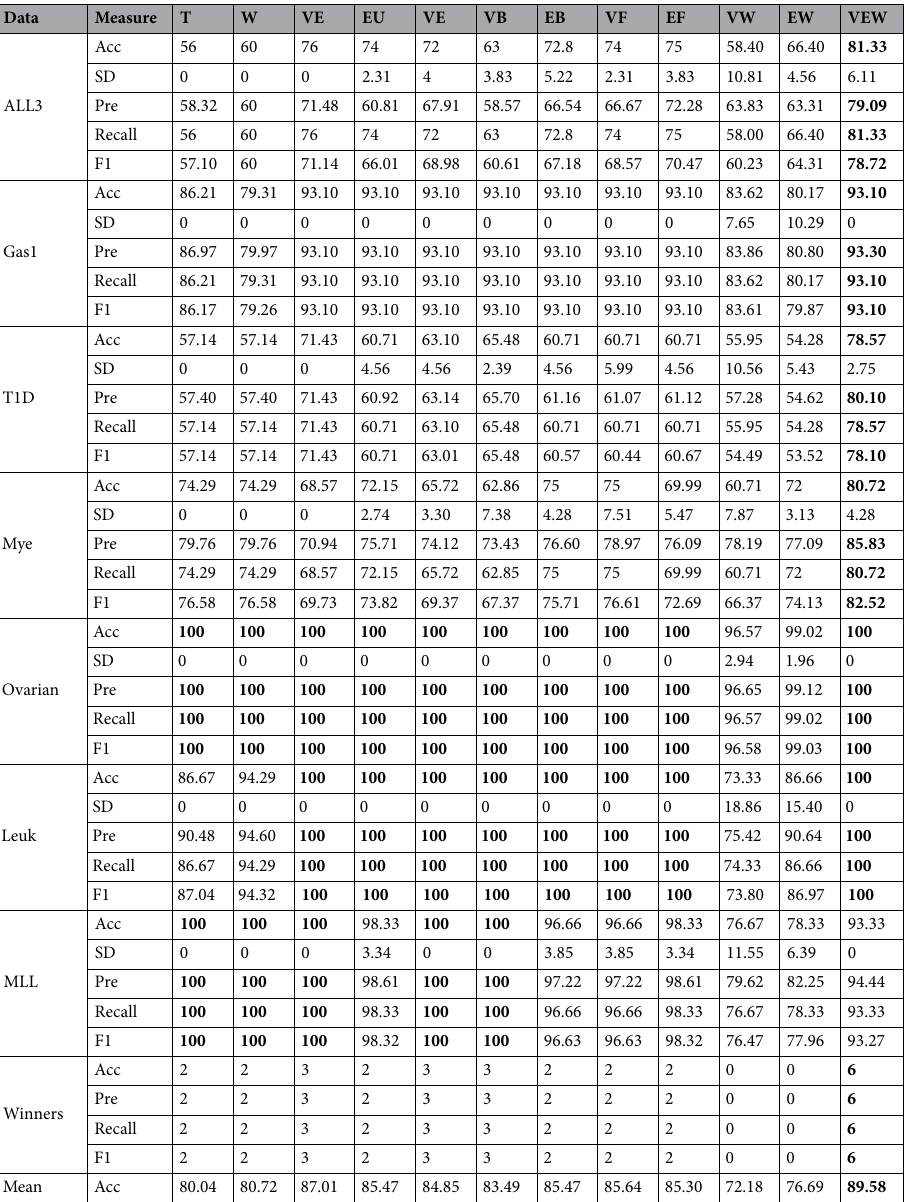
Table 3. Performance comparison of algorithms on classifier LR.